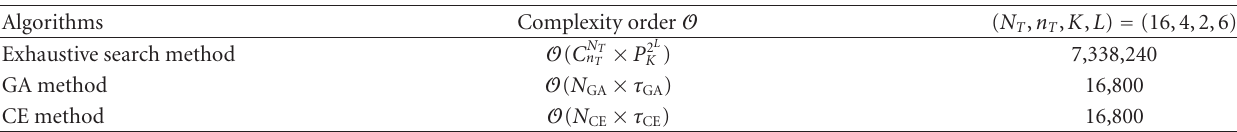
Table 1: Complexity of joint precoding and transmit antenna selection algorithms where n T is the number of selected transmit antennas, K donates the number of users, L donates the number of feedback bits, N N T is the number of total antennas, size and iterations used in the GA algorithm, and N CE and τ CE are the population size and iterations used in the CE method.